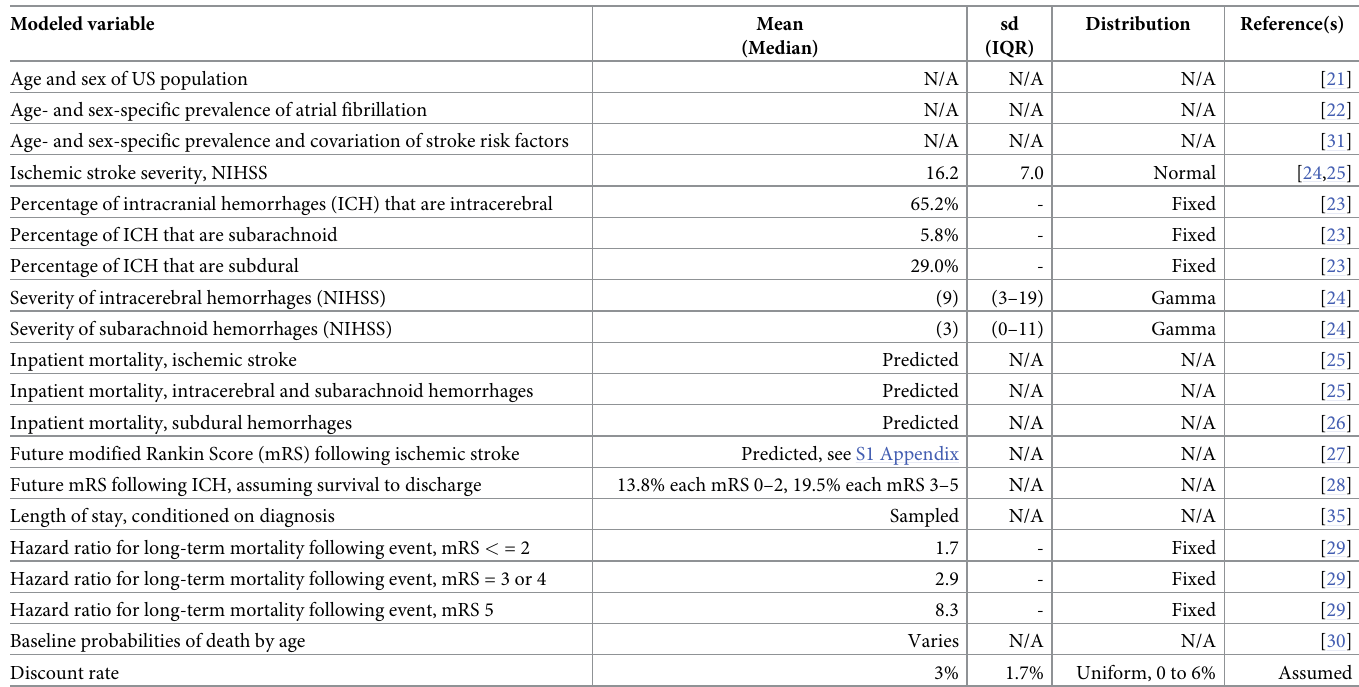
Table 1. Sources of estimates used to build simulation